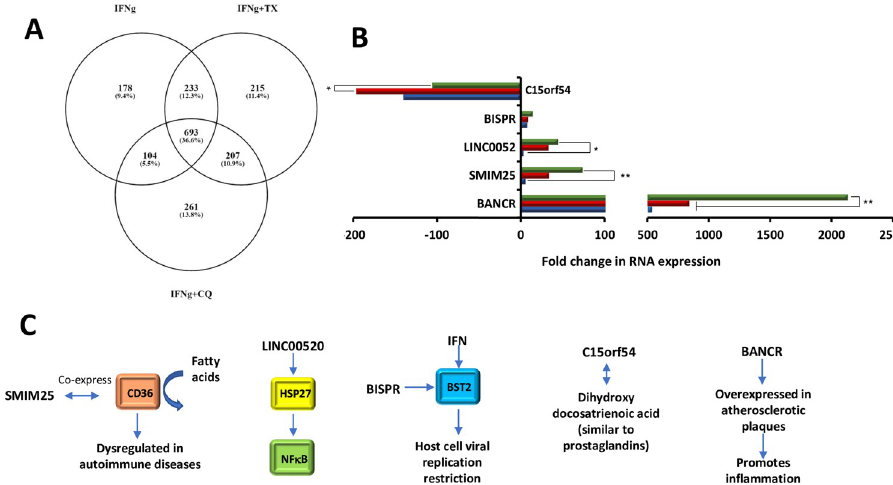
Fig 6. lincRNAs involved in MIAMI cells’ response to inflammation. A: A: Venn diagram showing numbers and percentages of unique and overlapping differentially regulated lincRNAs; B: Fold changes in selected lincRNAs; C: Putative functions of the selected molecules; Green bar IFN γ , Red IFN γ +TX, blue IFN γ +CQ. Values that are significantly different are indicated by bars and asterisks as follows: � , P � 0.05; �� , P � 0.01.